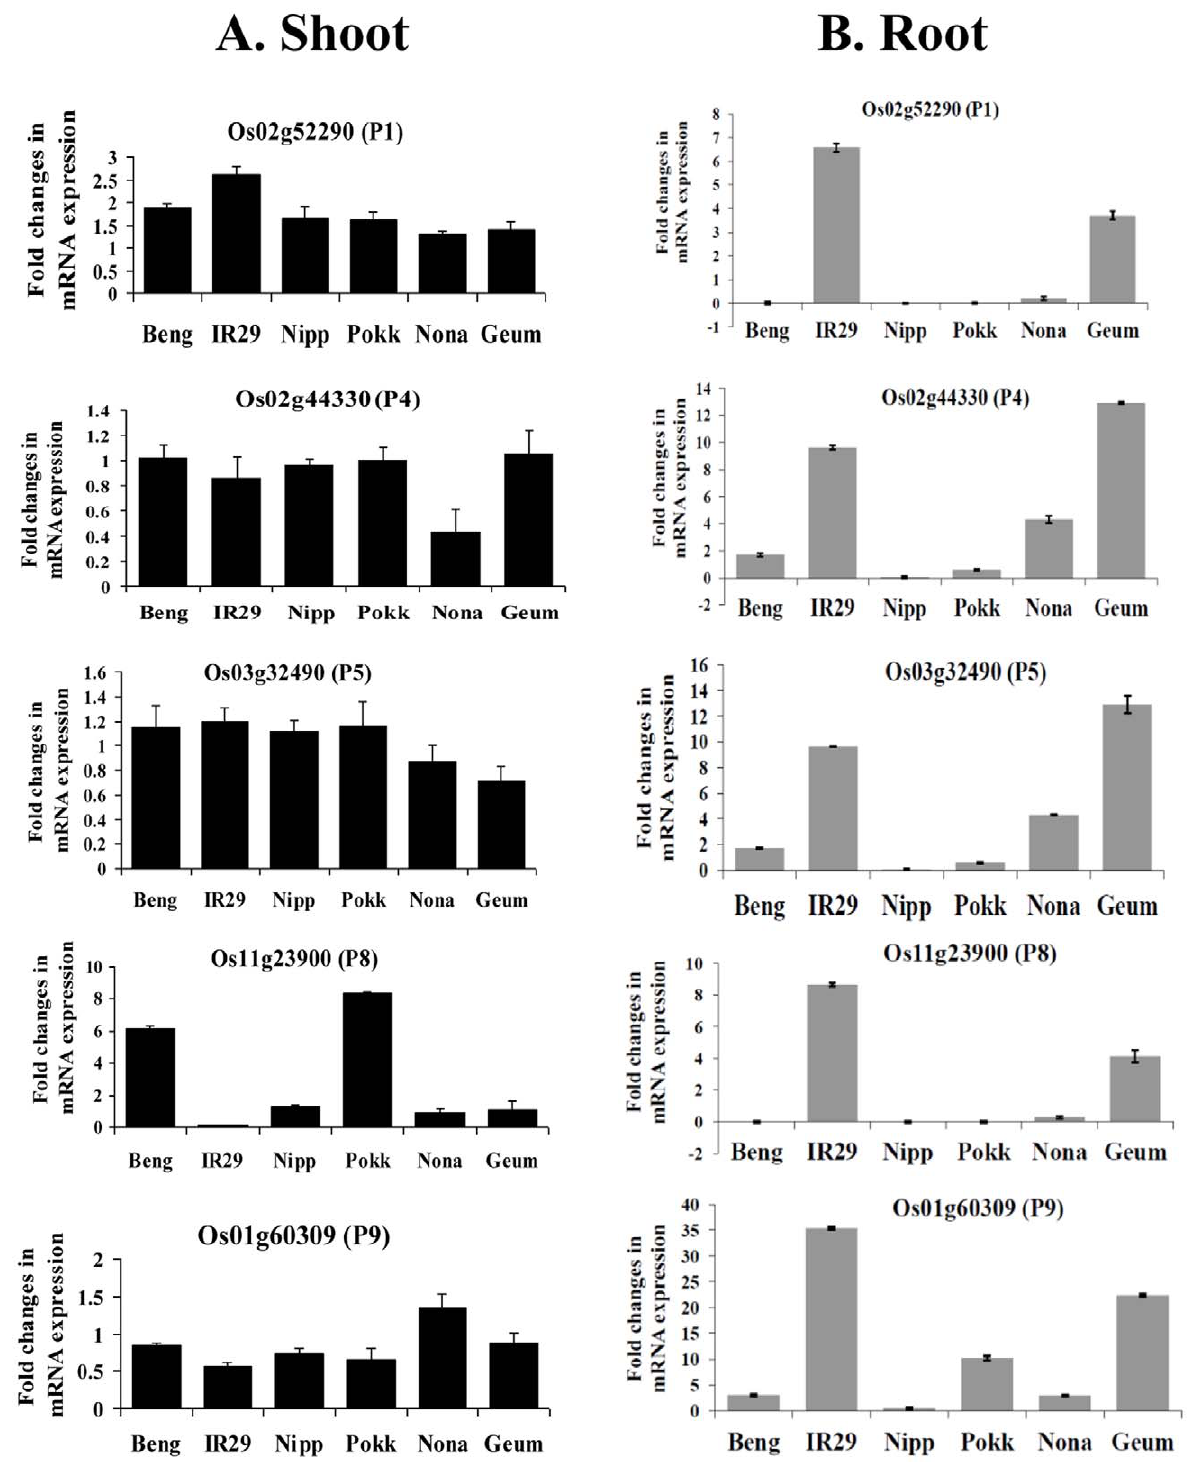
Figure 2. Expression profiles of MSAP loci in rice under salt stress. Salinity stressed shoot (A) and root (B) of six genotypes of rice, Bengal (Beng), IR29, Nipponbare (Nipp), Pokkali (Pokk), Nonabokra (Nona), and Geumgangbyeo (Geum) were used for quantifying the expression of MSAP loci relative to control. Real-time PCR analysis was performed using gene-specific primers. The expression of each gene in different RNA samples was normalized with the expression of internal control gene, rice elongation factor 1 a ( eEF1 a ). Fold changes in mRNA expression for each candidate gene in different genotypes were calculated relative to its control using ddCt method. The values represented are the mean of two biological replicates, each with three technical replicates. Error bars indicate the standard deviation.